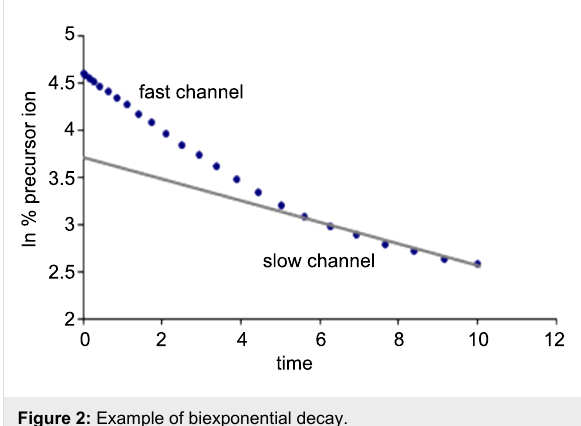
Figure 2: Example of biexponential